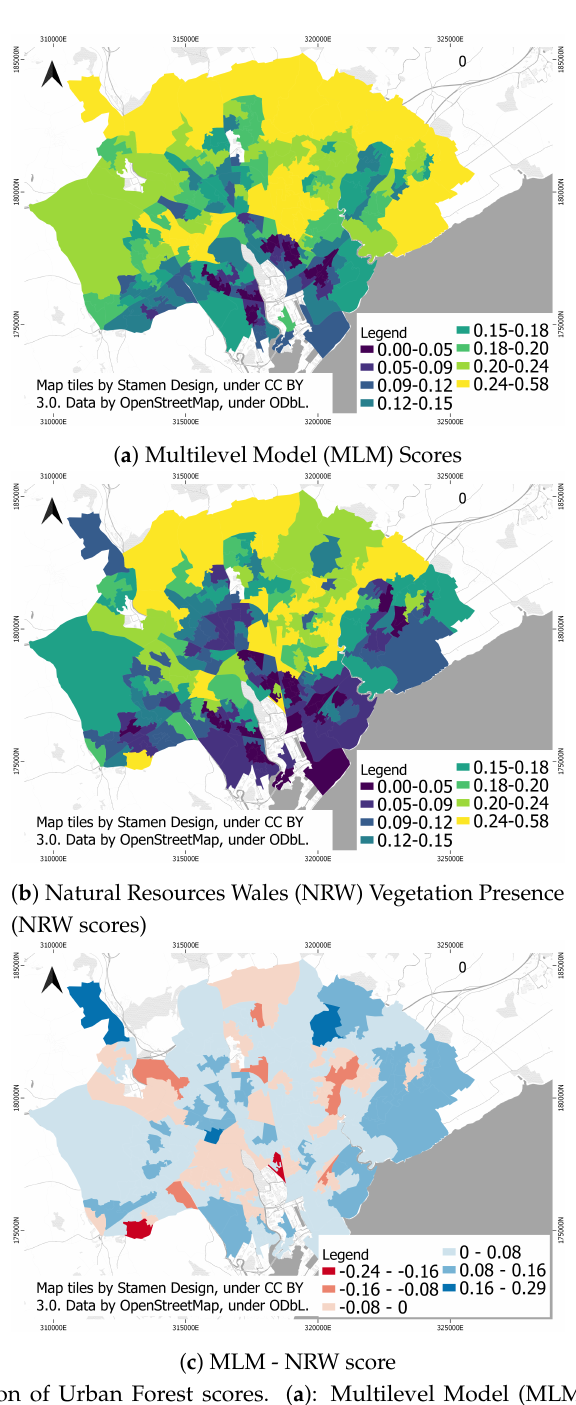
Figure 9. Comparison of Urban Forest scores. ( a ): Multilevel Model (MLM) Scores. ( b ): NRW vegetation percentage cover scores. ( c ): the difference between the MLM score and the NRW vegetation